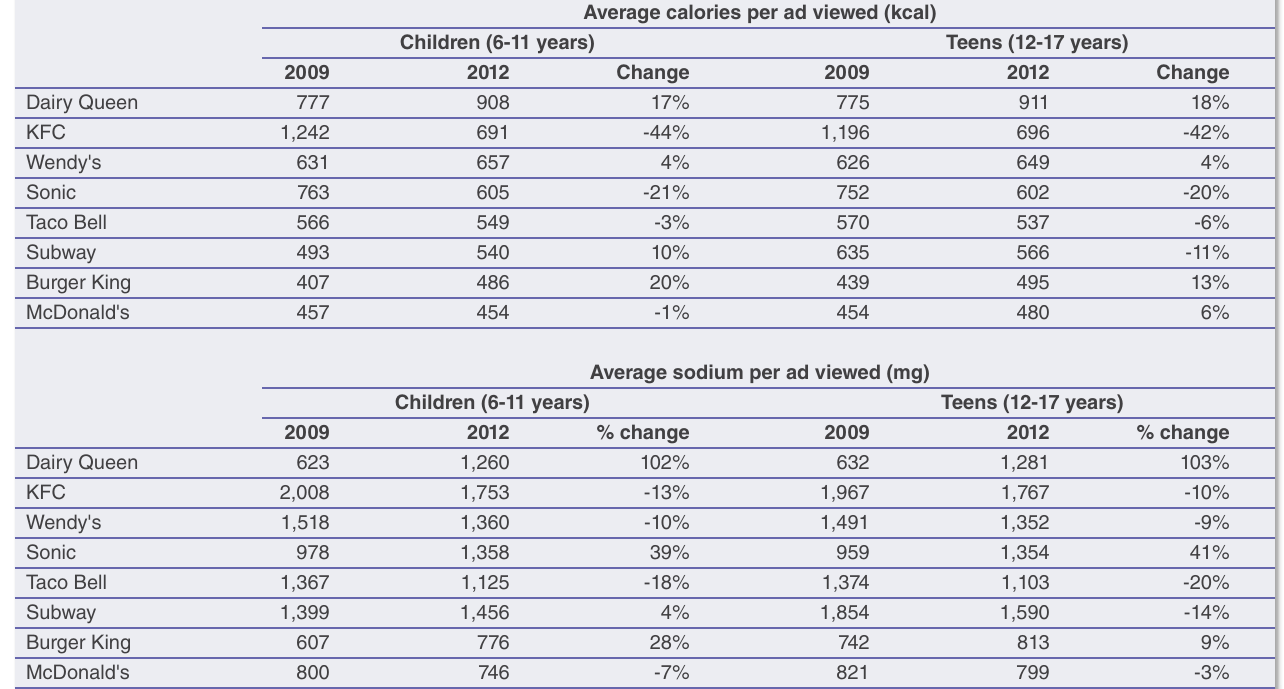
Table 24. Average calories and sodium in TV ads viewed by children and